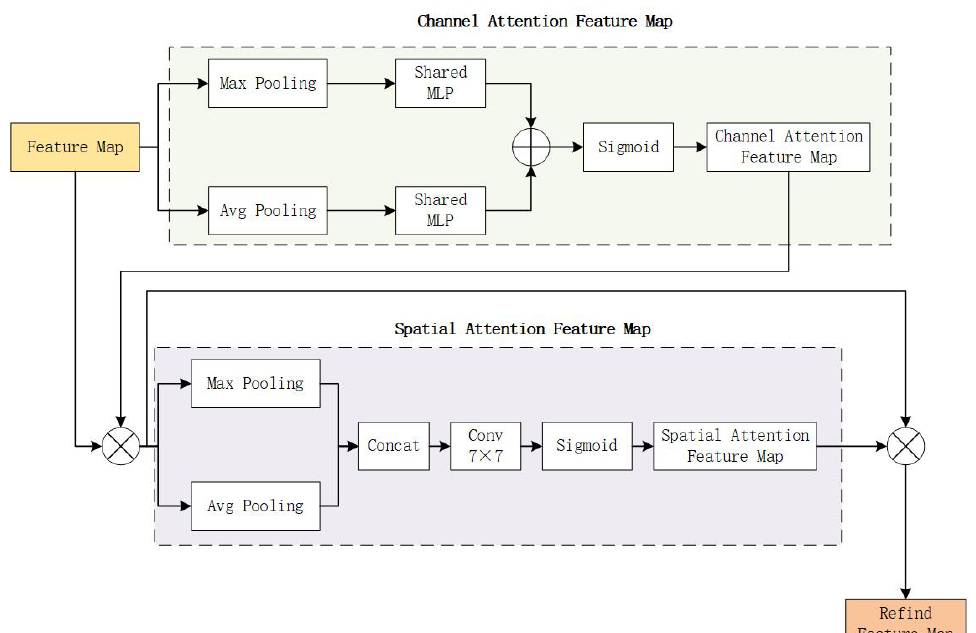
Figure 7. Fusion attention mechanism